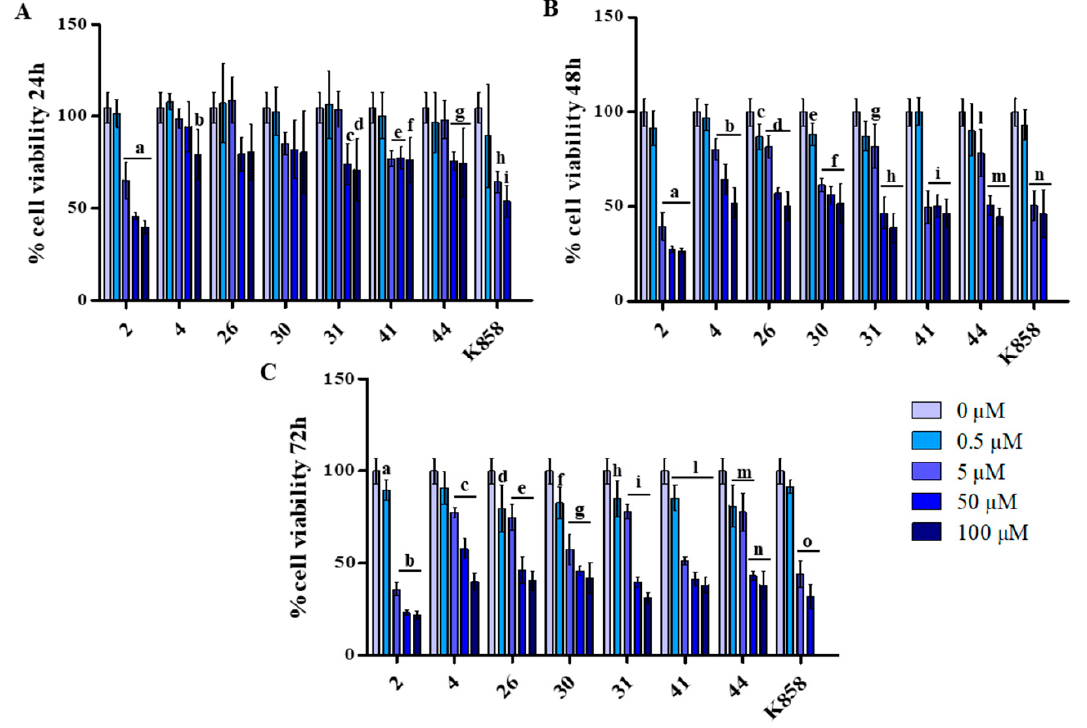
Figure 2. MTT assay on MCF7 cells exposed to compounds 2, 4, 26, 30, 31, 41, 44, and K858 (from 0.5 to 100 μ M) for 24, 48, and 72 h (A, B, and C, respectively). Metabolic activity was normalized with control cells treated with DMSO (0.2% as final concentration). DMSO: control vehicle. Data shown represent the mean ± SD of three independent experiments. ( A ) 2: a = p < 0.0001 0 μ M vs. 5–